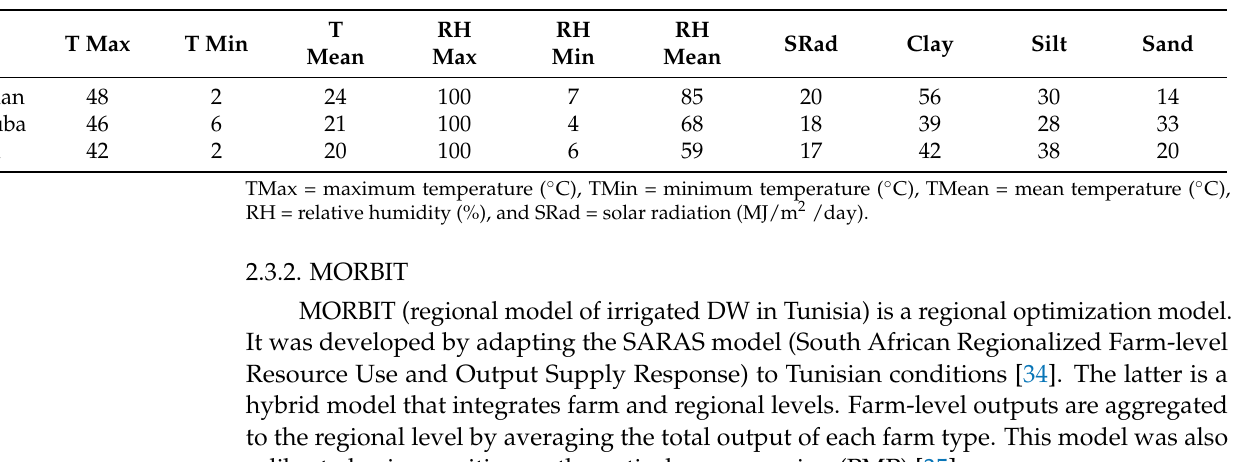
Table 1. Climate and soils description (average of campaigns 2014/2015 to